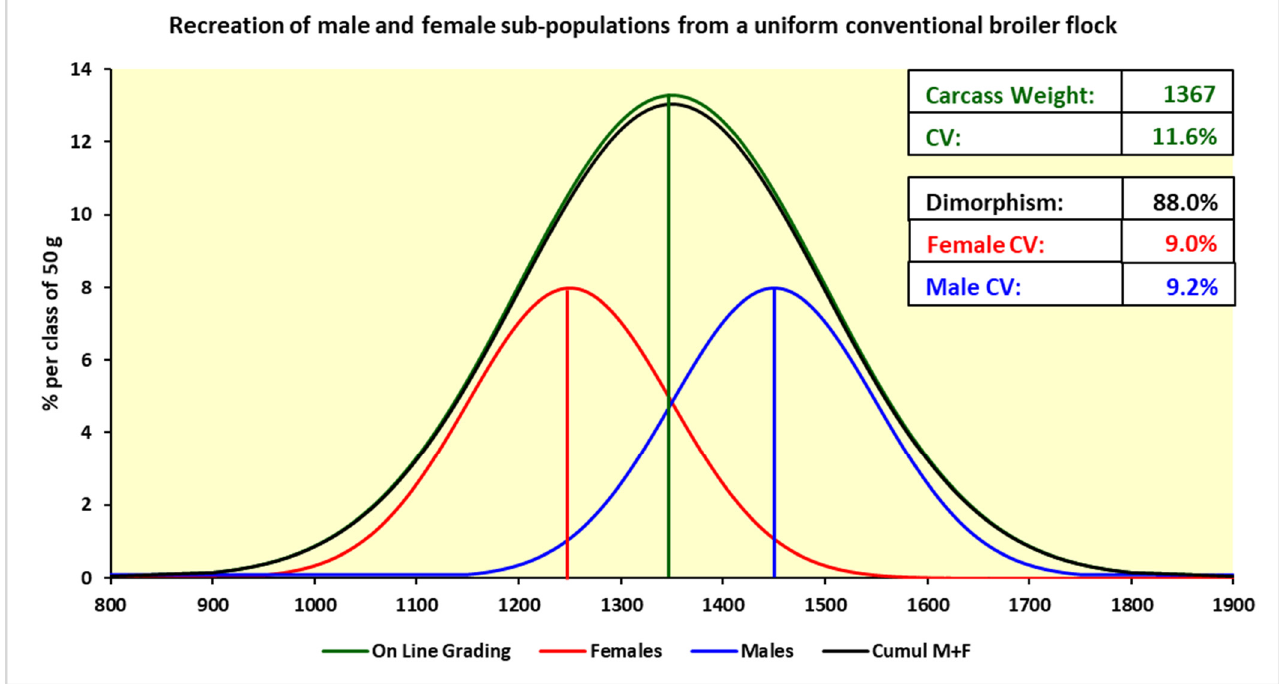
Figure 2. Sub-populations of males and females taken from as hatched conventional broiler flocks, redrawn to show the characteristics of on line weighing. Recreated from Toudic [9] with permission.